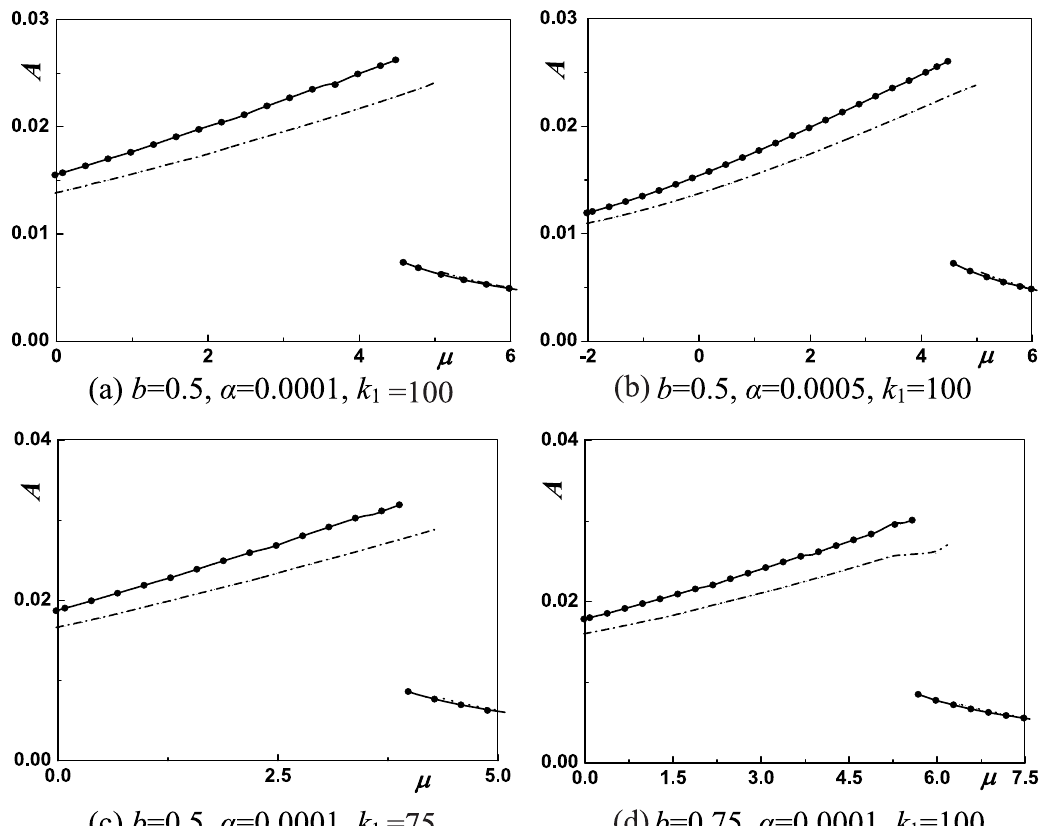
Fig. 2. The steady-state responses calculated from three models in the first resonance. Based on the numerical solutions of Eqs (6), (7), and (8), the differences between the models can be investigated via the shape of beams in the resonances. Figure 3 shows the shapes of beams in the first resonances for different nonlinear coefficients, load amplitudes, and viscosity coefficients. In Fig. 3, the dots, the dash-dot lines and the solid lines stand for the numerical solutions to Eqs (6), (7), and (8), respectively. In all cases, results from Eq. (7)